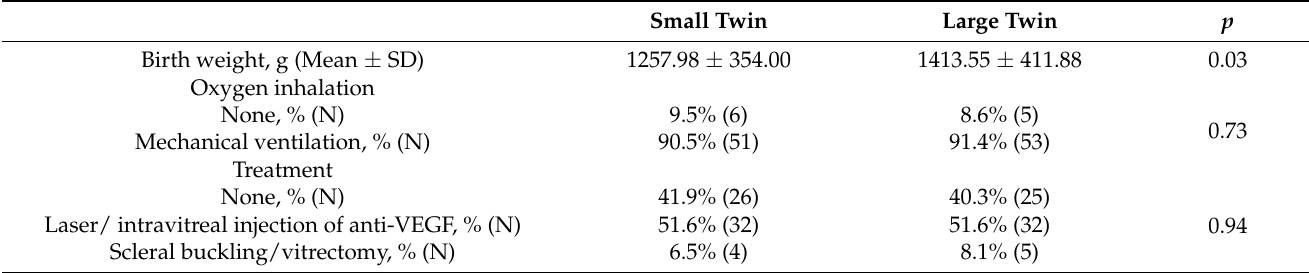
Table 2. Characteristics and treatments of infants grouped according to small or large